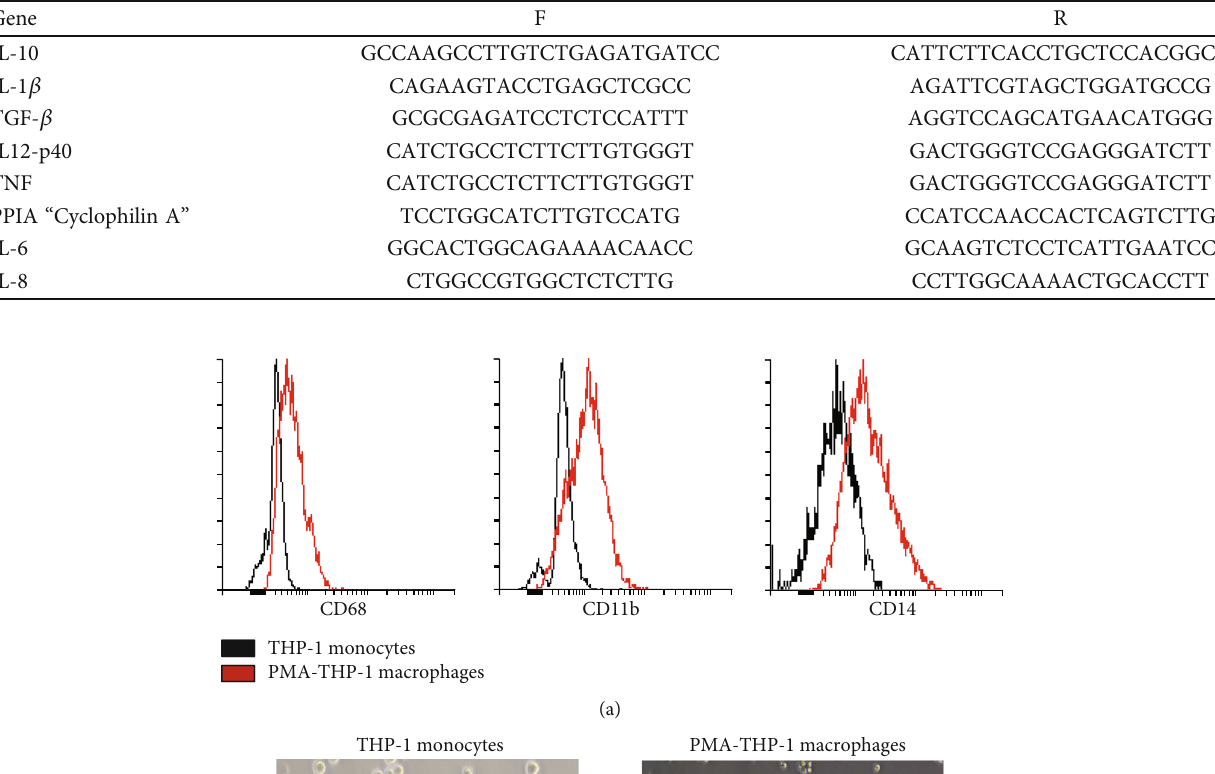
Table 1: Primer set of in fl ammatory cytokines.